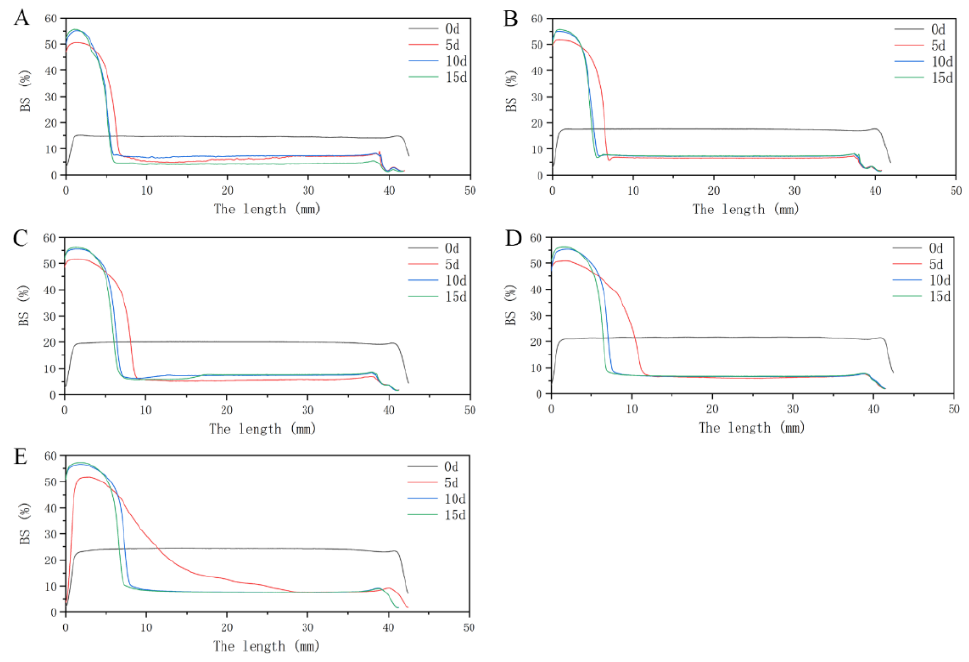
Figure 3. Back scattering (BS) of WPI solutions over storage time under static conditions. ( A ) 3% WPI solution; ( B ) 4% WPI solution; ( C ) 5% WPI solution; ( D ) 6% WPI solution; ( E ) 7% WPI solution.